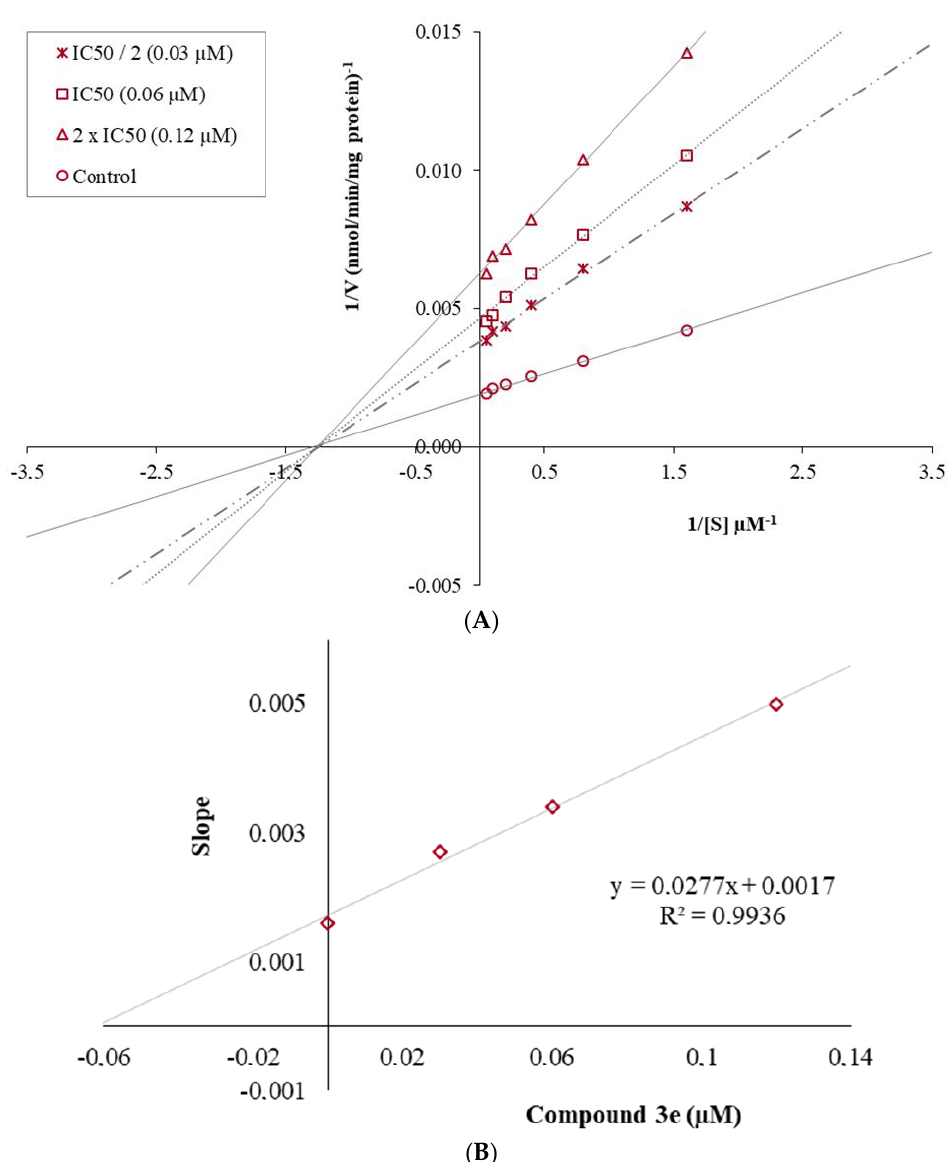
Figure 2. ( A ) Lineweaver–Burk plots for the inhibition of h MAO B by compound 3e . [S], substrate concentration (μM); V, reaction velocity (nmol/min/mg protein). Inhibitor concentrations are shown at the left. V max values from 2 × IC 50 to Control; 158.730, 212.766, 263.158, and 526.316 (nmol/min/mg protein). K m value of the non-competitive inhibition; 0.767±0.031 (µM). ( B ) Secondary plot for the calculation of the steady-state inhibition constant (K i ) of compound 3e . K i was calculated as 0.061 μM.